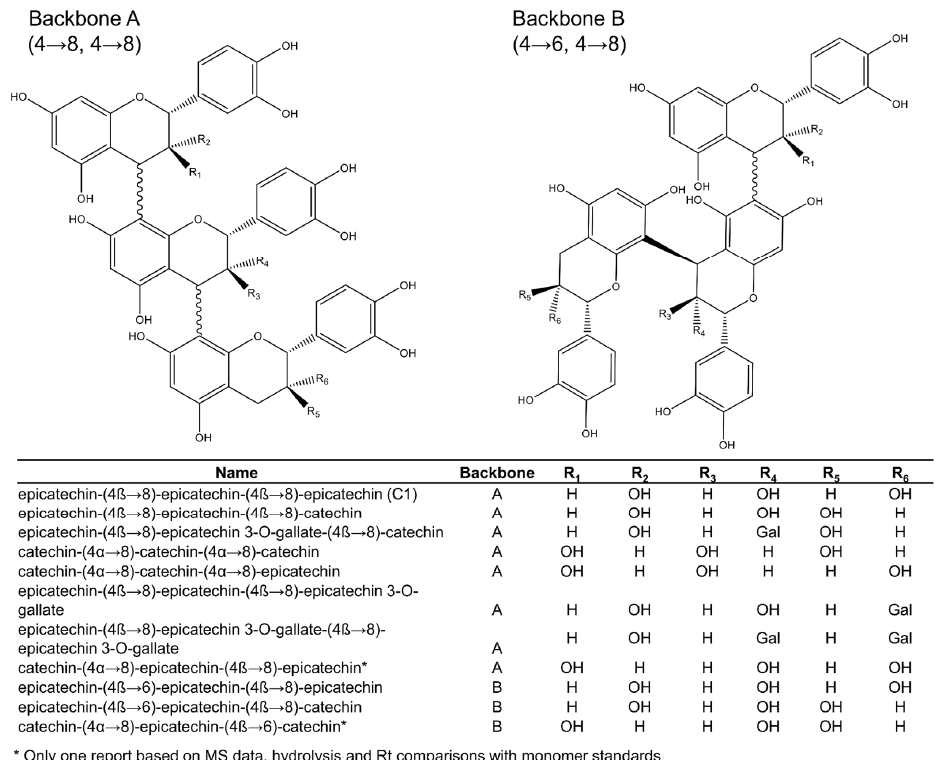
Figure 3. Procyanidin trimers (backbones A and B) reported in grape seeds.